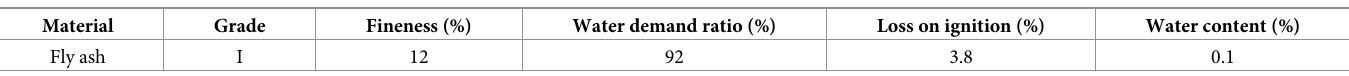
Table 4. Property indices of the fly ash.